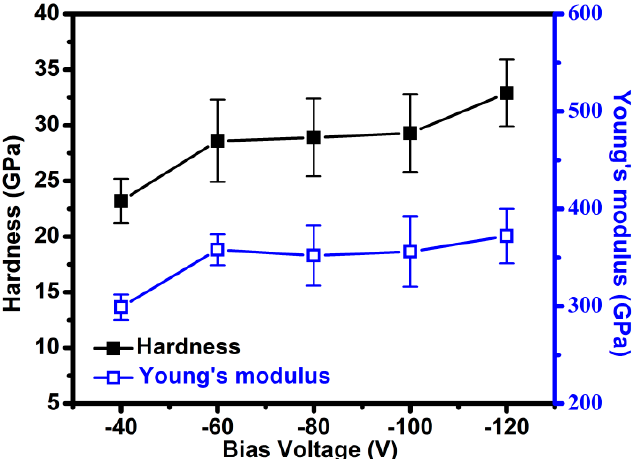
Figure 8. Nanoindentation results of AlCrCN films as a function of bias voltage.